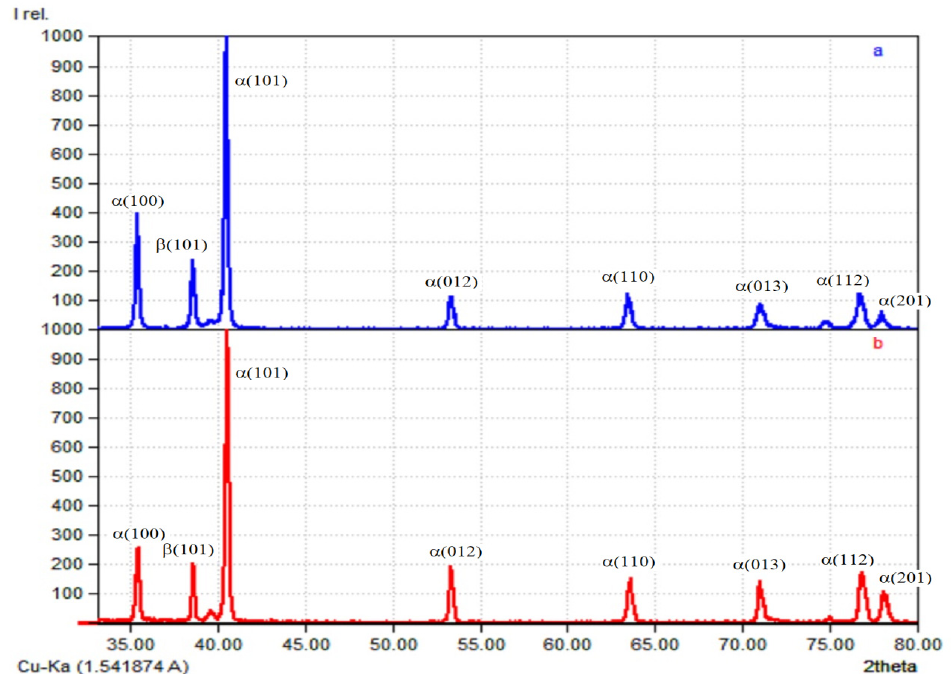
Figure 12. Diffractogram of specimens obtained by CMT deposition: ( a ) without forging; ( b ) with forging.